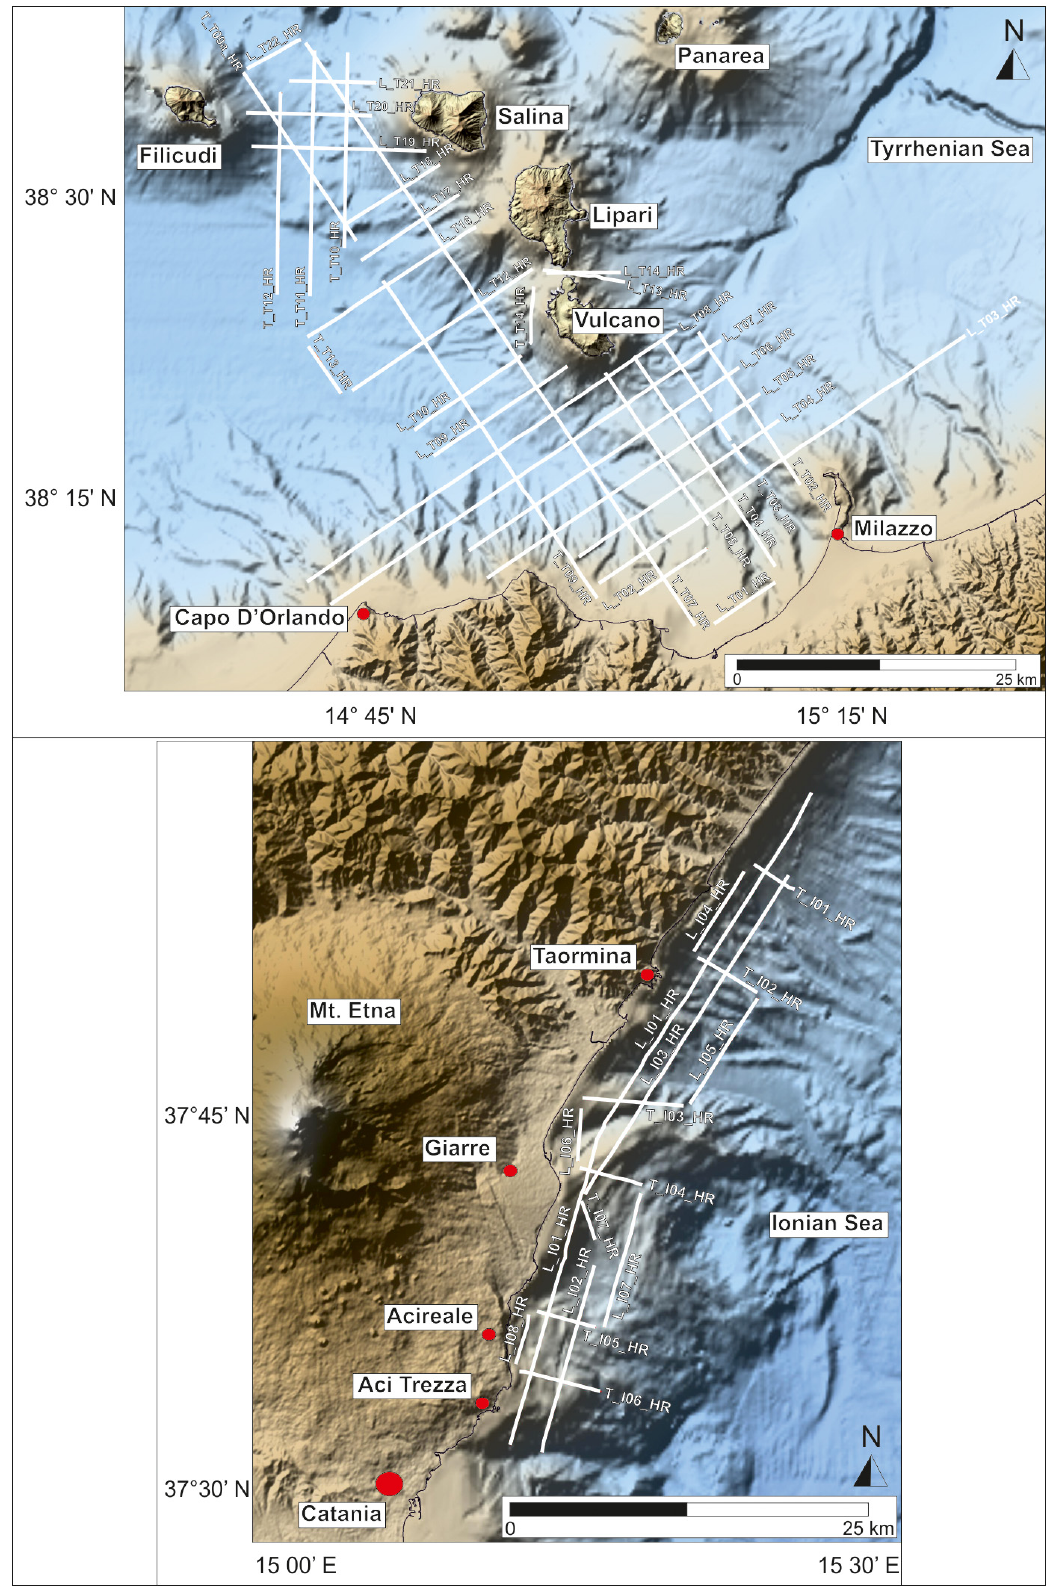
Figure 3. Acquisition map in the Tyrrhenian (top) and Ionian (bottom) Seas during the TOMO-ETNA experiment with R/V